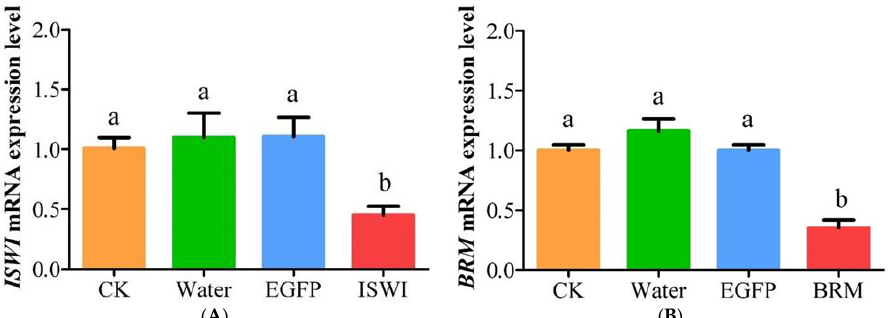
Figure 3. Effects of double-stranded RNA (dsRNA) treatment on TaISWI ( A ) and TaBRM ( B ) mRNA expression. Controls consisted of uninjected female pupae (CK) and those injected with water or EGFP dsRNA. Expression levels are means ± SEM. Bars with different lowercase letters indicate significant differences between treatment means at p < 0.05.